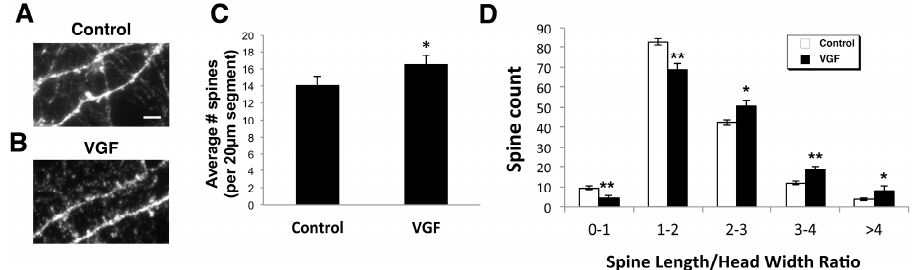
Figure 2. VGF overexpression increases immature spine formation. ( A , B ) Representative images of AAV infected hippocampal cultures (14–20 DIV) treated with AAV-GFP (control) ( A ) or AAV-VGF-GFP (VGF) ( B ); The signal was enhanced with GFP immunohistochemistry. Scale bar = 5 µ m; ( C ) Quantification of spine density. Bars represent average number of spines per 20 µ m dendritic segment ± SEM ( n = 6 dishes, 15 segments/dish); ( D ) quantitation of spines in Green Fluorescent Protein (GFP) or VGF (non-acronymic) treatment groups based on ratio of spine length/head width ± SEM ( n = 4 dishes, 225 spines/dish). Two-sample t -test of control vs. VGF: ( C ) average number of spines t(22) = 4.66, p = 1.72 × 10 − 7 ; ( D ) spine length/head width ratio 0–1 t(14) = − 3.04, p = 0.003; 1–2 t(14) = 2.25, p = 0.002; 2–3 t(4) = 2.45, p = 0.032; 3–4 t(14) = 2.25, p = 0.008; >4 t(14) = 2.25, p = 0.038. * p < 0.05, ** p < 0.01 relative to control (unpaired t -test).